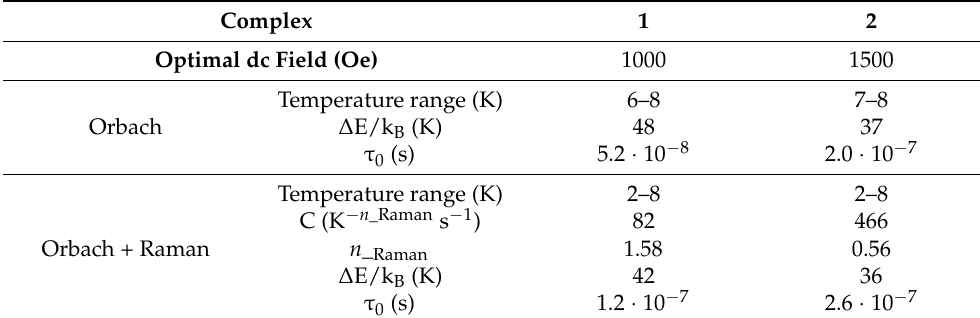
Table 2. Approximation of the τ (1/ T ) plots for complexes 1 and 2 using various relaxation